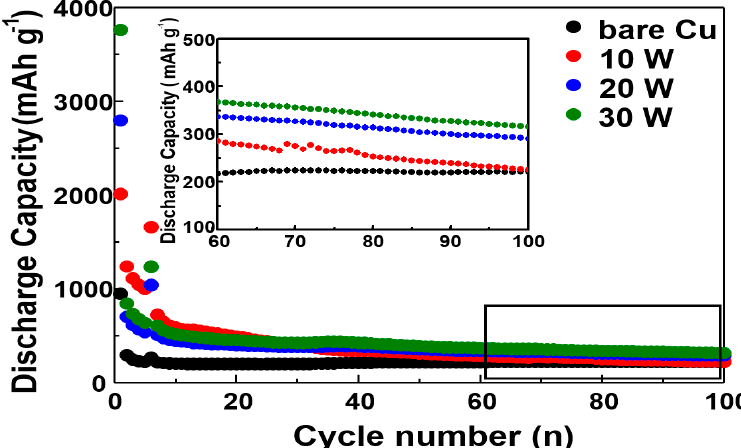
Figure 5. Comprehensive comparison of the initial discharge capacity and capacity retention of Figure 4a–d.